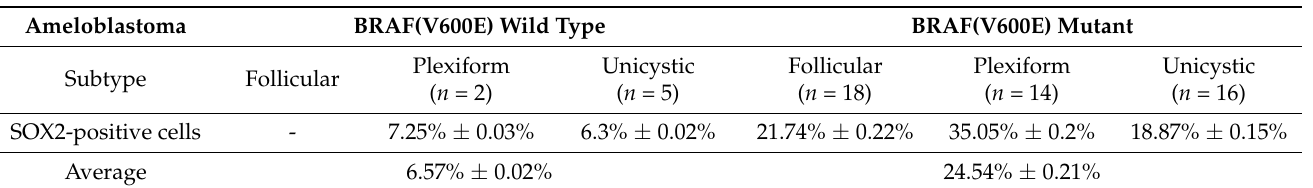
Figure 8. SOX2-positive rate distribution among BRAF(V600E) wild type (WT) and mutant cases. * p < 0.05. Table 6. SOX2-positive rate distribution among BRAF(V600E) wild type and mutant in different subtypes of the ameloblastoma cases in this study.